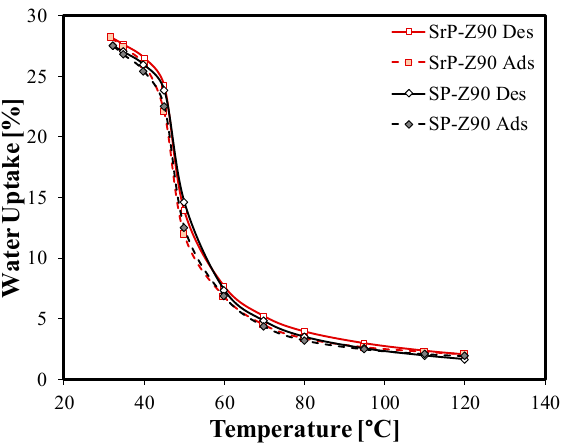
Figure 9. Water adsorption (filled marker) and desorption (empty marker) isobar at 11 mbar for SP-Z90 and SrP-Z90 composite coatings.